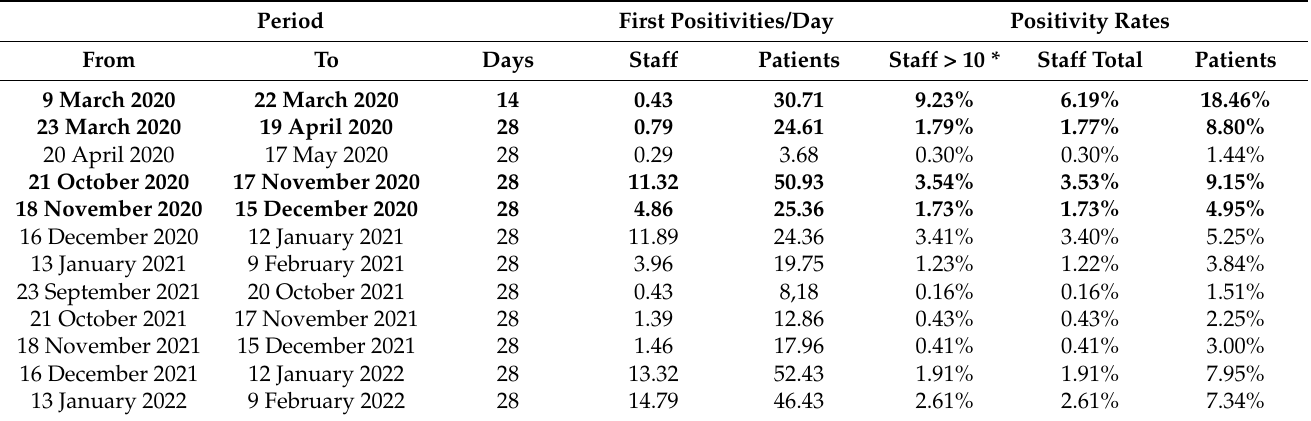
Table 2. The positivity rate in the staff and patient population (the rows referring to the periods immediately before and after the lockdowns, considering the beginning of each lockdown + 14 days, are highlighted in bold).